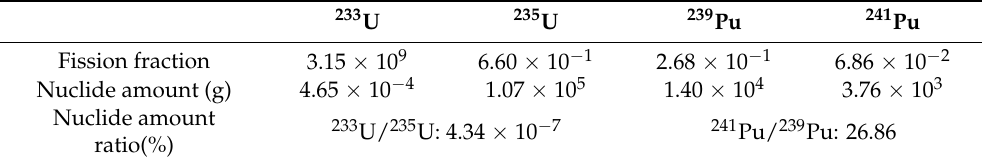
Table 2 states several burnup uncertainty calculation results. The result from perturb-